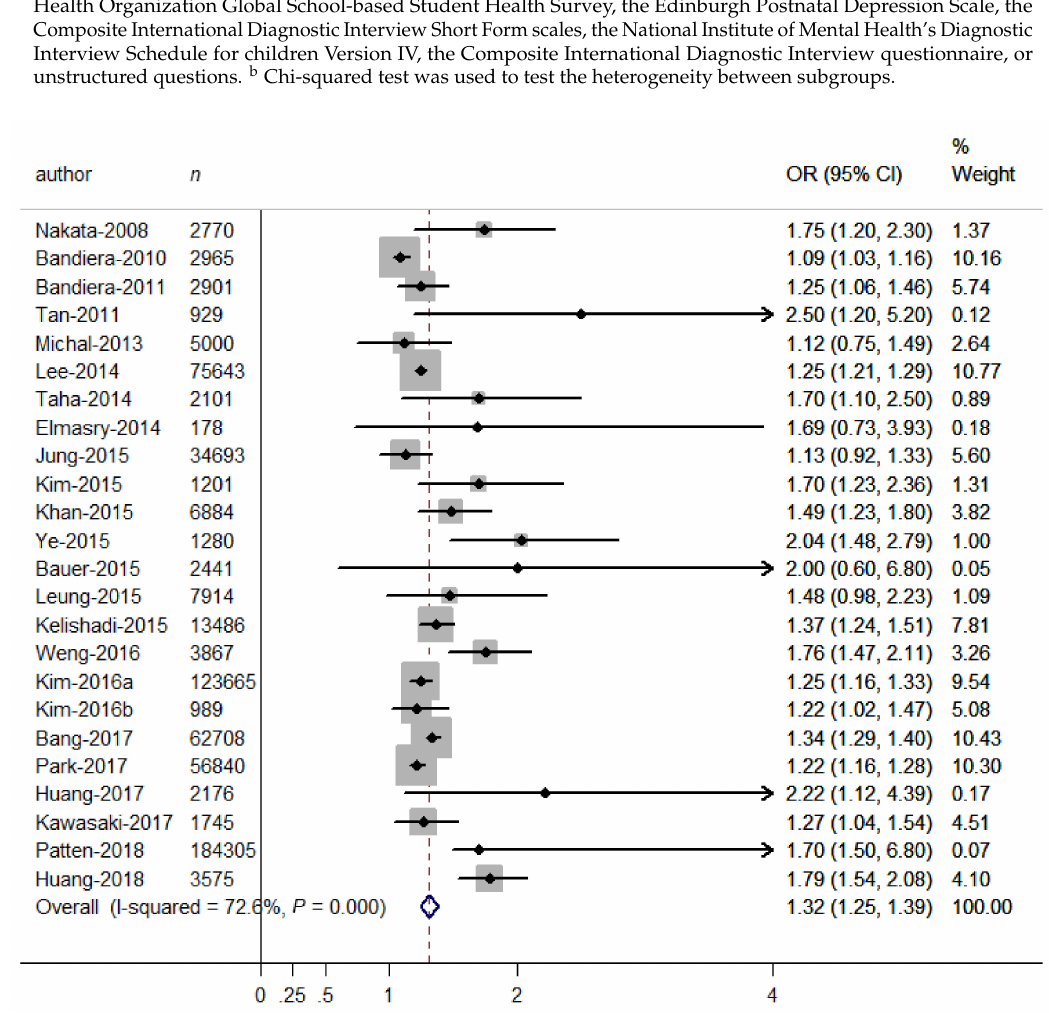
Figure 2. Forest plot for the association between binary SHS exposure (exposure vs. non-exposure) and depressive symptoms. Grey square represents the e ff ect estimate in each study, with square size reflecting the study-specific weight and the 95% CI represented by horizontal bars. The diamond indicates the summary e ff ect